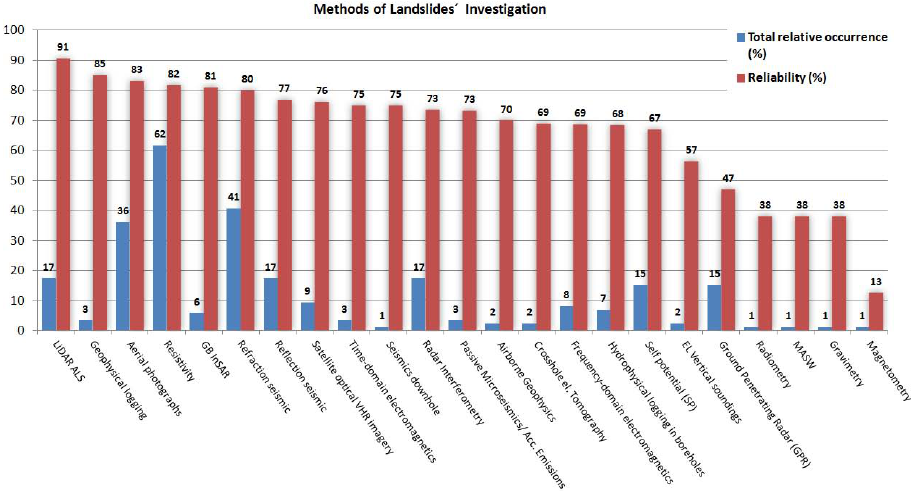
Fig. 12. Comparison of all of the evaluated methods of landslide investigation ordered by their reliability.